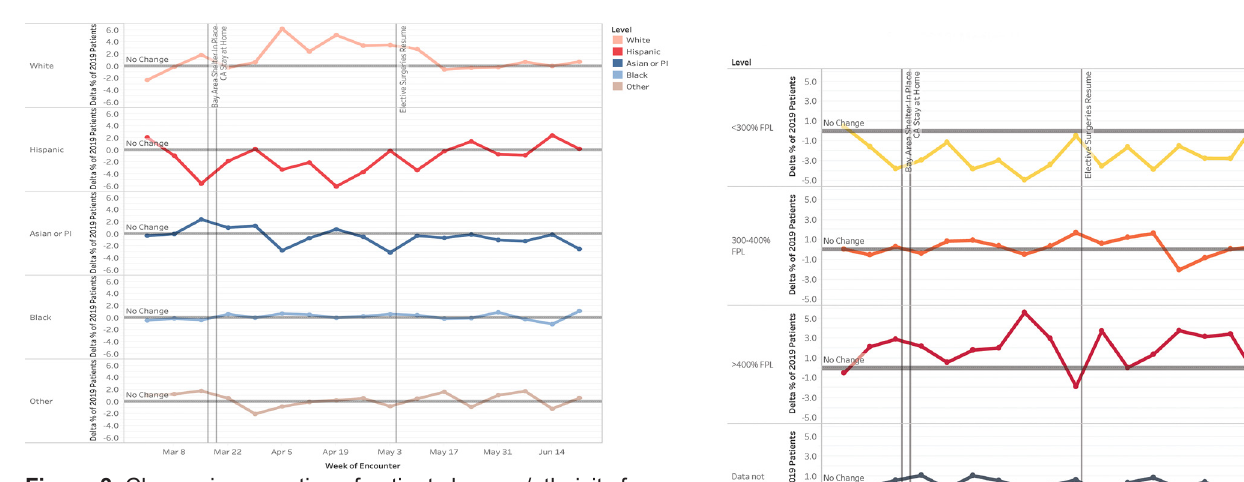
Figure 3. Change in proportion of patients by race/ethnicity for